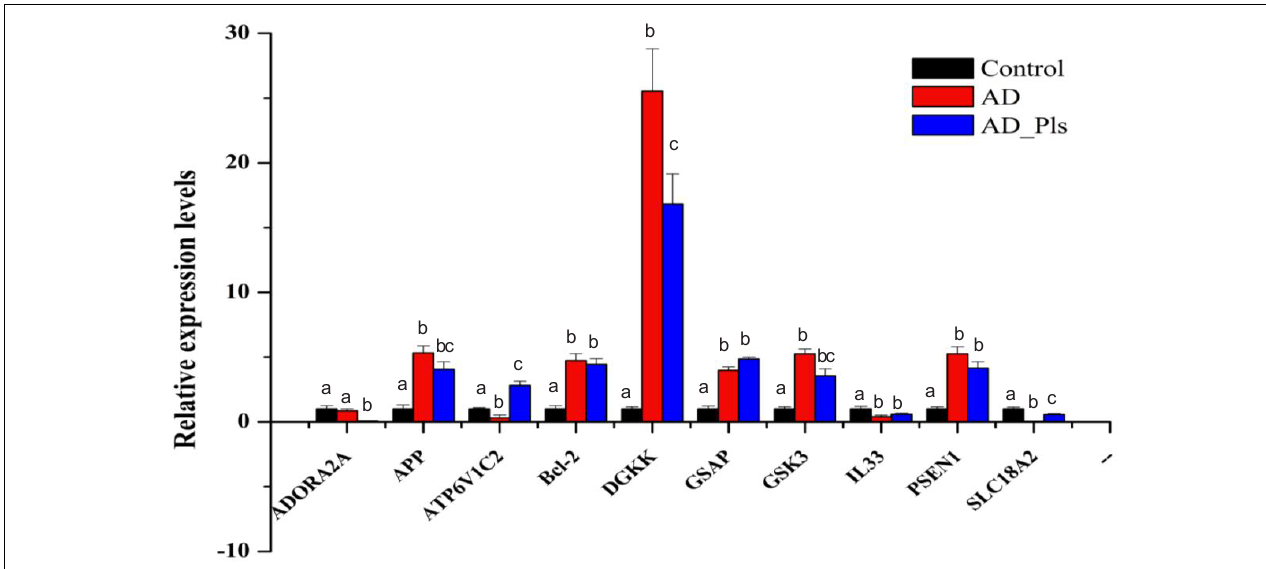
FIGURE 3 | A comparison of the expression levels of several genes in AD model, AD model + Pls, and control groups. These genes were selected as KEGG analysis indicated that they were AD-related ( APP, GSAP, GSK3, and PSEN1 ), autophagy-related ( Bcl-2 ), fatty acid metabolism-related ( DGKK ), or their mRNAs levels were significantly changed among different groups ( ATP6V1C2, SLC18A2, and IL33 ). The expression level of each gene in the control group was set as 1, and that in AD and AD_Pls groups was quantified relative to it. GAPDH was selected as an endogenous control. The results were represented as average ± SD ( n = 3), and different letters denoted a significant difference between each group at p < 0.05 (Duncan’s new multiple range test).